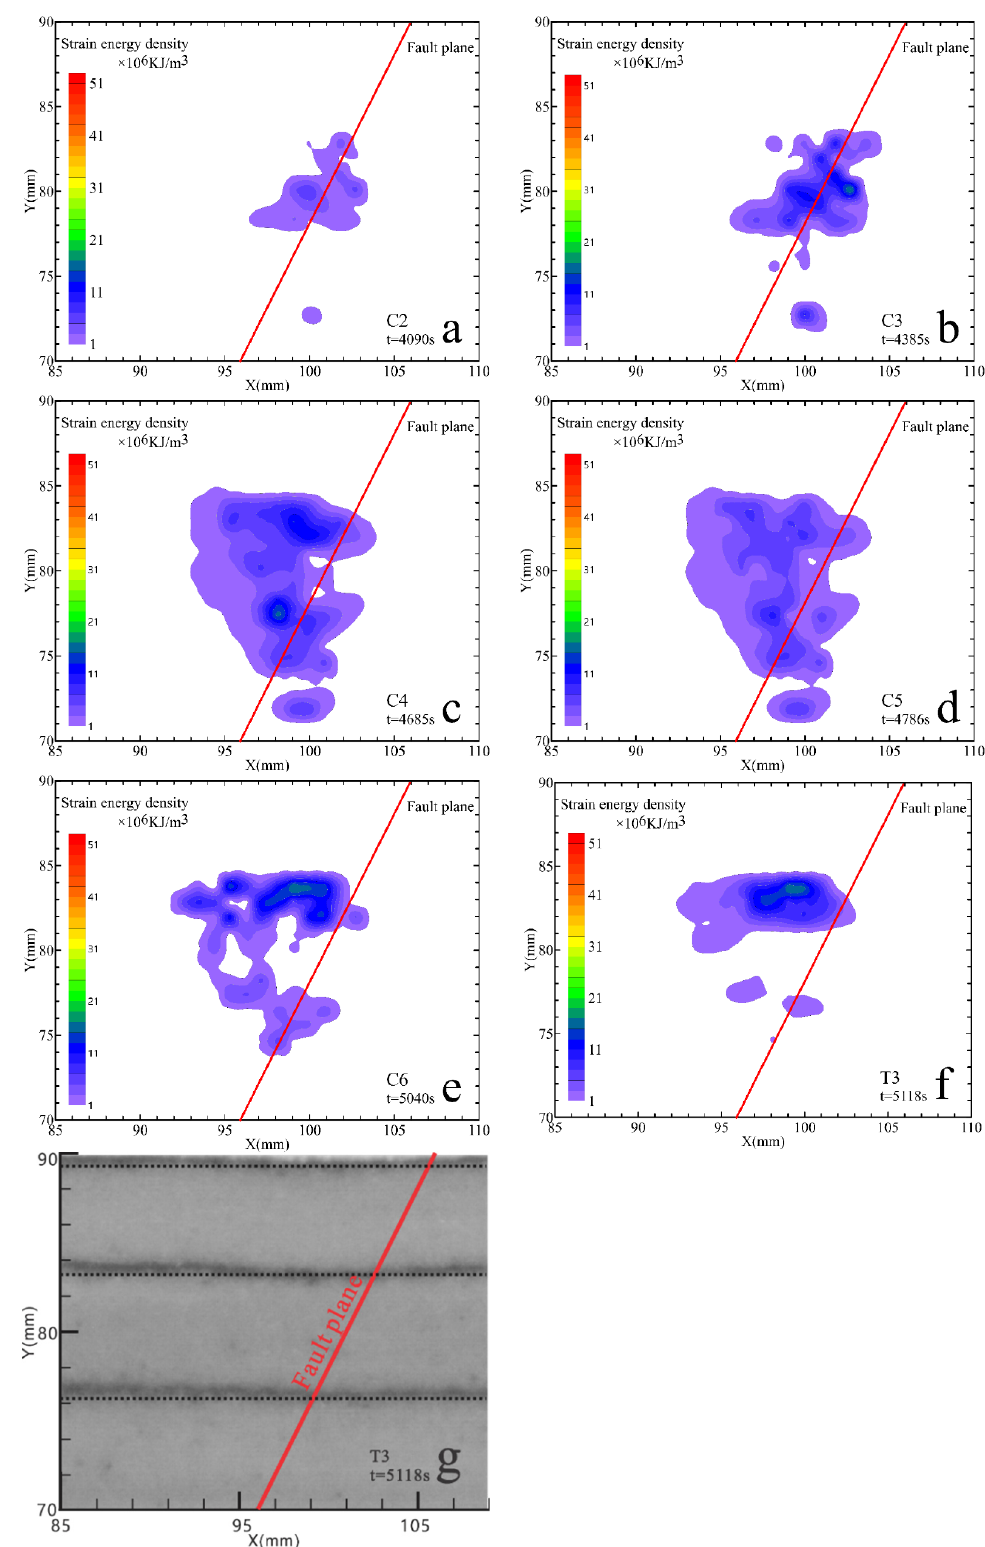
Figure 13. Strain energy density distribution at ( a ) C2, t = 4090 s; ( b ) C3, t = 4385 s; ( c ) C4, t = 4685 s; ( d ) C5, t = 4786 s; ( e ) C6, t = 5040 s; ( f ) T3, t = 5118 s; and, ( g ) T3, t = 5118 s, the normal fault evolution observed from the simulation chamber.